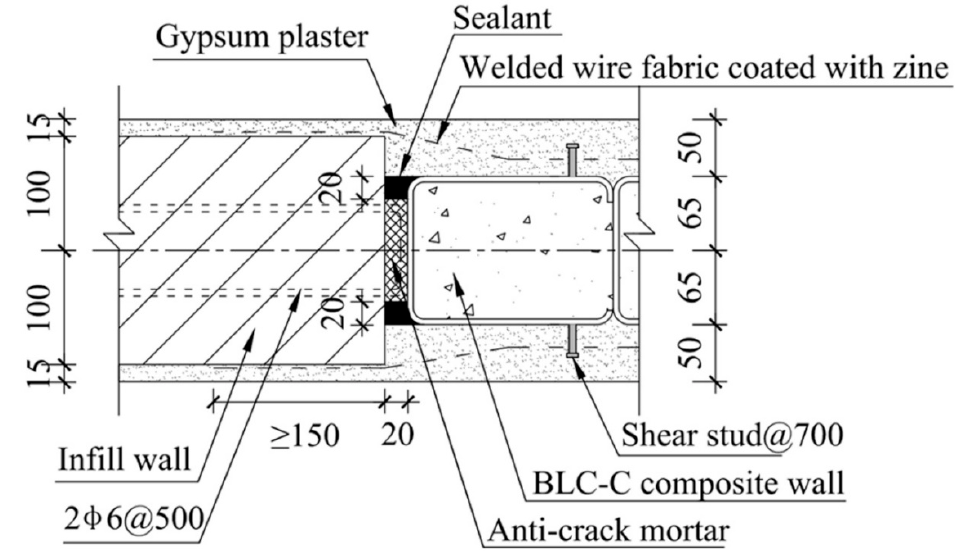
Figure 2. Connection structure of the interface (using anti-crack mortar; units in mm).